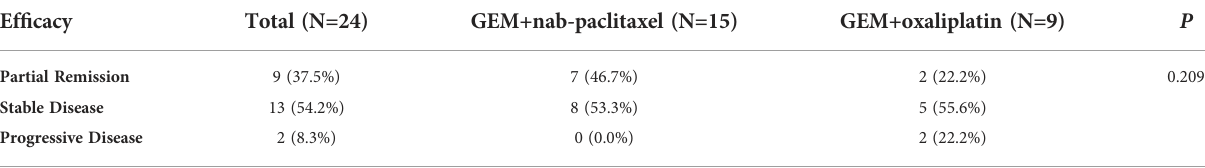
TABLE 2 Ef fi cacy of chemotherapy in the nab-paclitaxel group and oxaliplatin